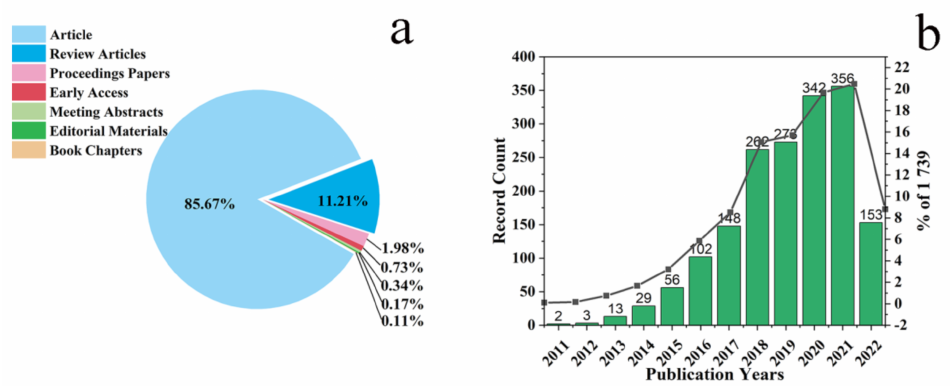
Figure 1. ( a ) Documents by type used for bibliometric analysis; ( b ) publications per